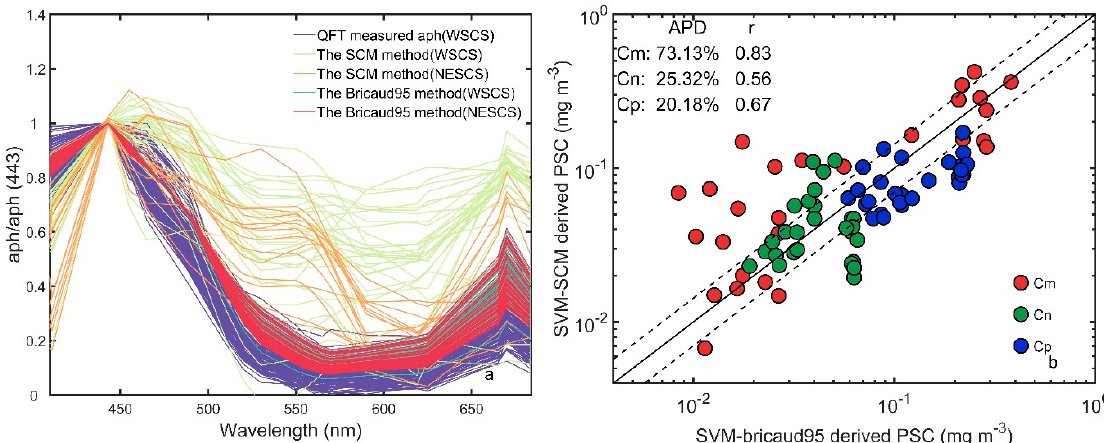
Figure 12. Scatter plots of PSC derived using SVM-SCM PSC versus SVM-Bricaud95 ( a ). a ph (443)- Figure12. ScatterplotsofPSCderivedusingSVM-SCMPSCversusSVM-Bricaud95( a ). a ph (443)-specific specific absorption coefficients of phytoplankton reconstructed by Bricaud95 methods ( b ). Black line absorption coe ffi cients of phytoplankton reconstructed by Bricaud95 methods ( b ). Black line represents represents the 1:1 line and dotted lines represent the 1:1 line ± 30% log 10 PSC. the 1:1 line and dotted lines represent the 1:1 line ± 30% log 10